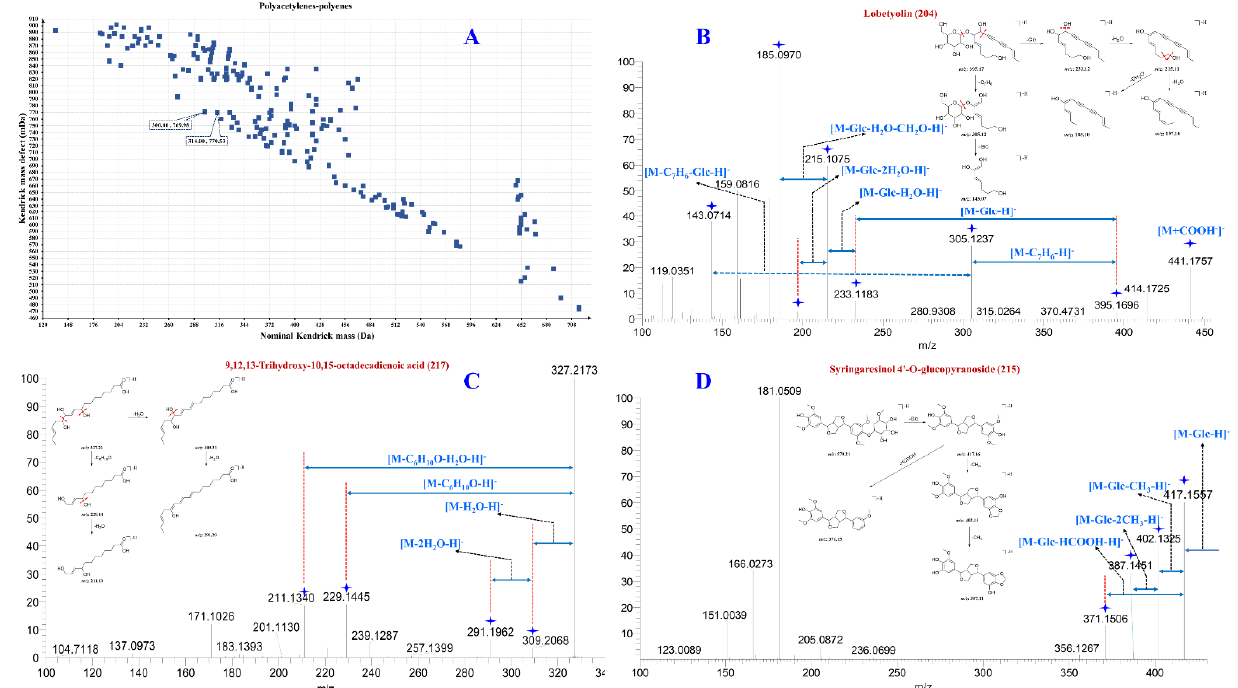
Figure 4. The KMDF scatter plot depicted the m / z values of potential polyenes and polynephthenes in Shenqi Fuzheng Injection (SFI), the MS/MS spectra of the representative polyene and polycynes, and the possible MS fracture patterns. (( A ), KMDF scatter plot of potential polyene and polycynes; ( B ), lobetyolin; ( C ), 9,12,13-Trihydroxy-10-octadecadienoic acid; ( D ), syringaresinol 4 ’ - O -glucopyranoside).